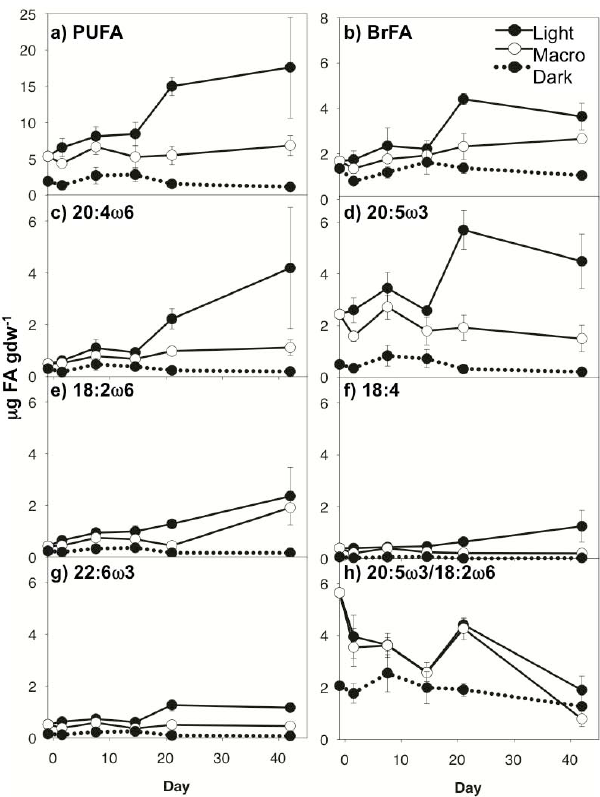
Fig. 5. Concentrations of select algal and bacterial PLFA in sur- face (0–1cm) sediments. (a–g) are in units ofµgFAgdw − 1 . (h) is unitless since it is a ratio of concentrations. Values are mean ± SE ( n = 4).